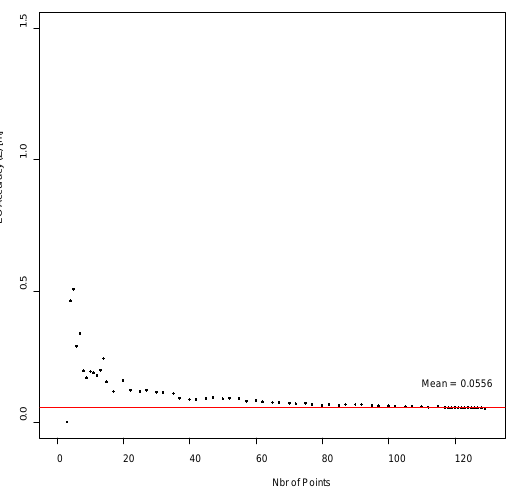
Figure 5. EO accuracy in dependence of the number of